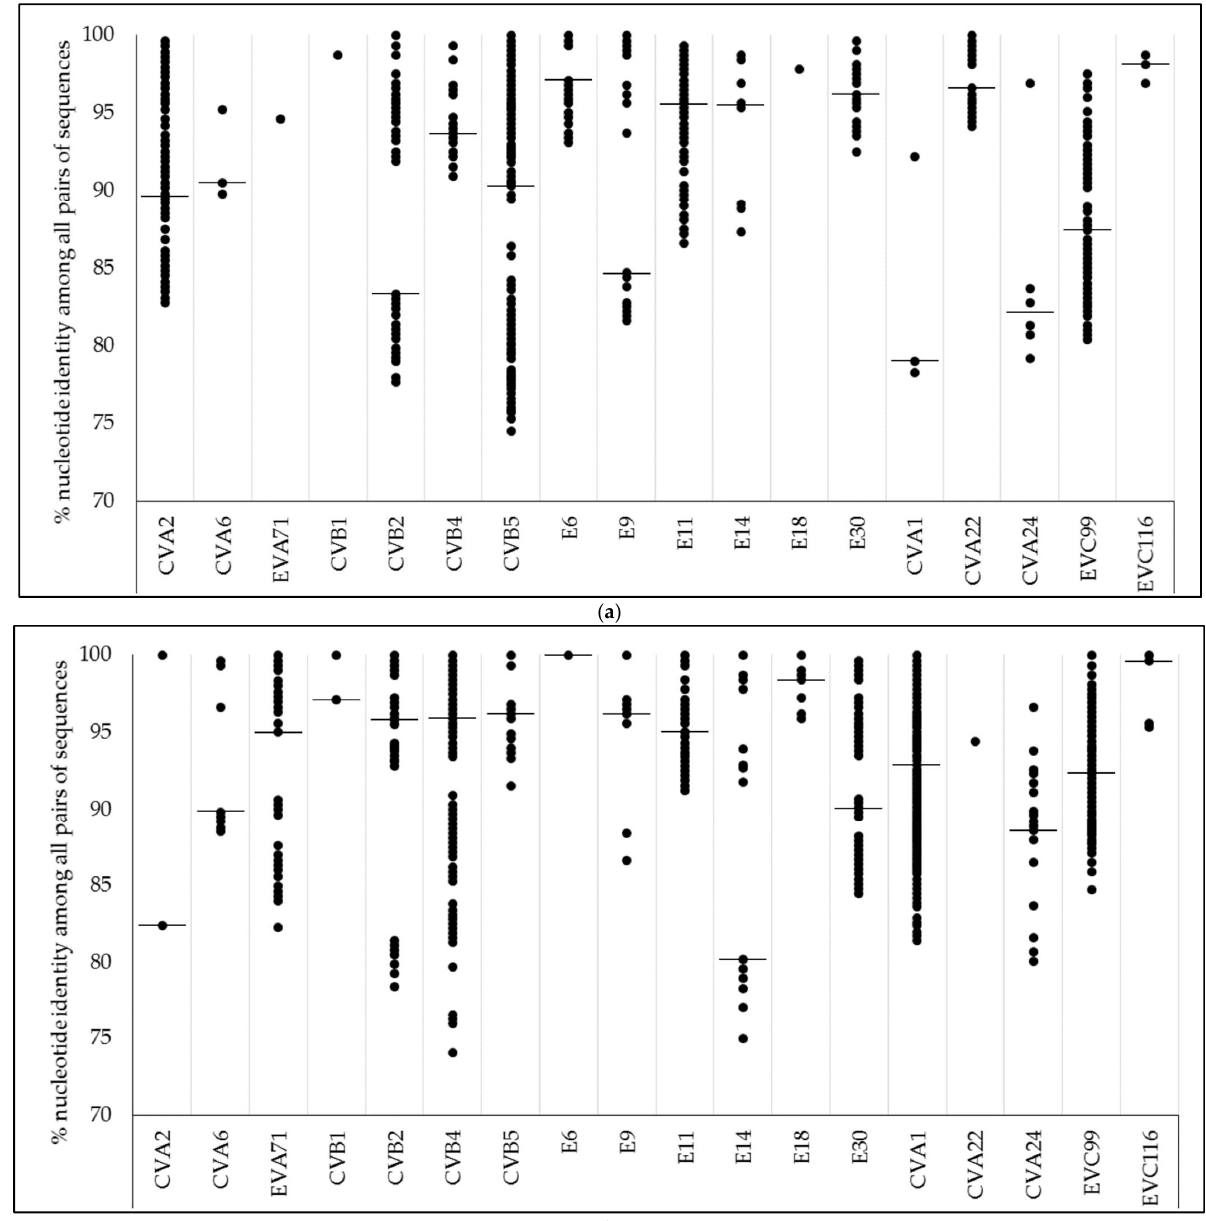
Figure 2. Nucleotide identity values over all the centroid sequences pairs for each Human Enterovirus type detected in wastewater samples from Córdoba City, Argentina in both periods ( a ) 2011–2012 and ( b ) 2017–2018. Horizontal bars indicate the median of nucleotide identity when more than a pair of centroid sequences was detected.